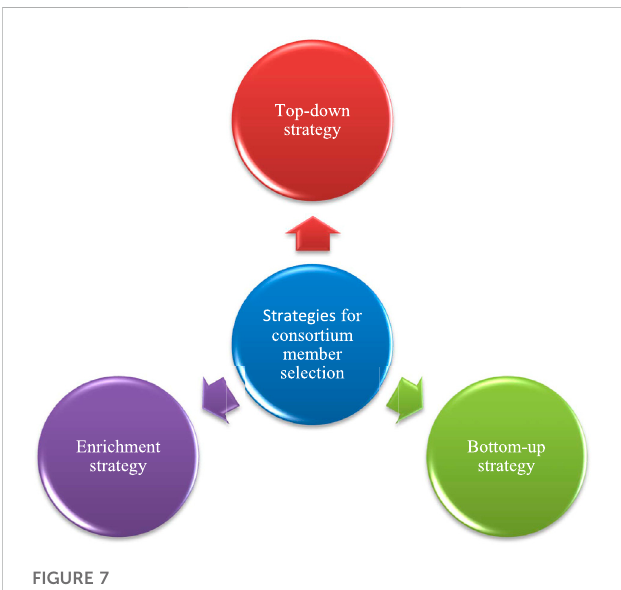
FIGURE 7 Strategies for the selection of consortium members in